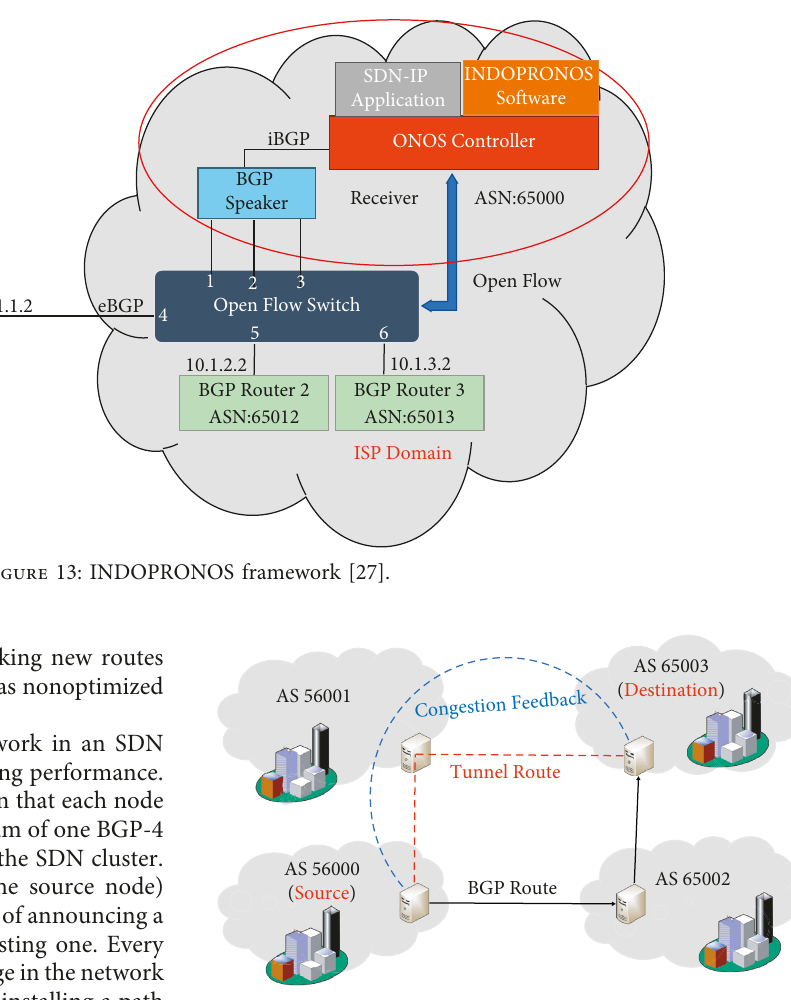
Figure 14: Architecture overview of ETMP-BGP [15]).